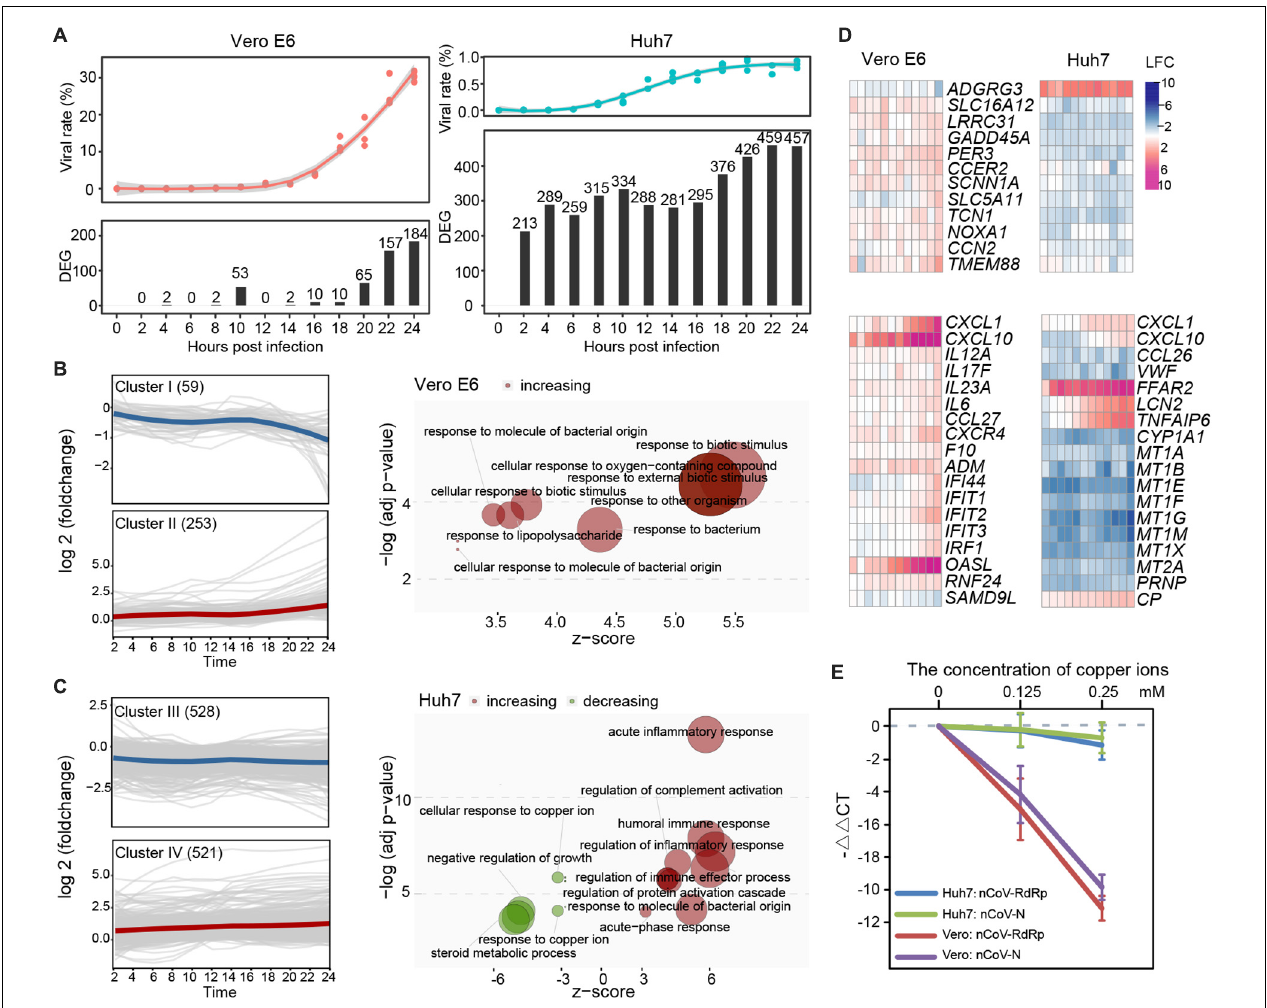
FIGURE 2 | Comparative analysis between SARS-CoV-2-induced response on Vero E6 and Huh7 cells during 24 h. (A) Proportion of SARS-CoV-2 and distribution of DEGs in two cell lines during infection. (B,C) Functionality of DEG sets with different expression patterns in Vero E6 and Huh7, respectively. Unsupervised clustering based on k-medoids algorithm was performed on DEGs of two cell lines, and resulting clusters were subjected to GO enrichment analysis. Downregulated gene set cluster I in Vero E6 was not enriched for functional terms with P < 0.05. (D) Noteworthy characteristics of DEGs are highlighted. (E) SARS-CoV-2 viruses were suppressed by addition of different concentrations of copper ions in vitro . RdRp and N of SARS-CoV-2 in cell culture supernatant were detected separately, and – (cid:49)(cid:49) Ct (i.e., log2foldchange) was calculated using blank group as